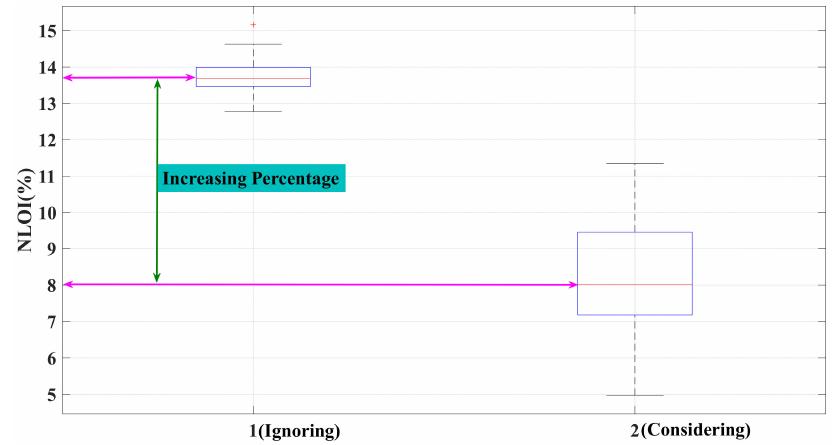
Figure 12. The NLO indexes of lines for different scenarios.